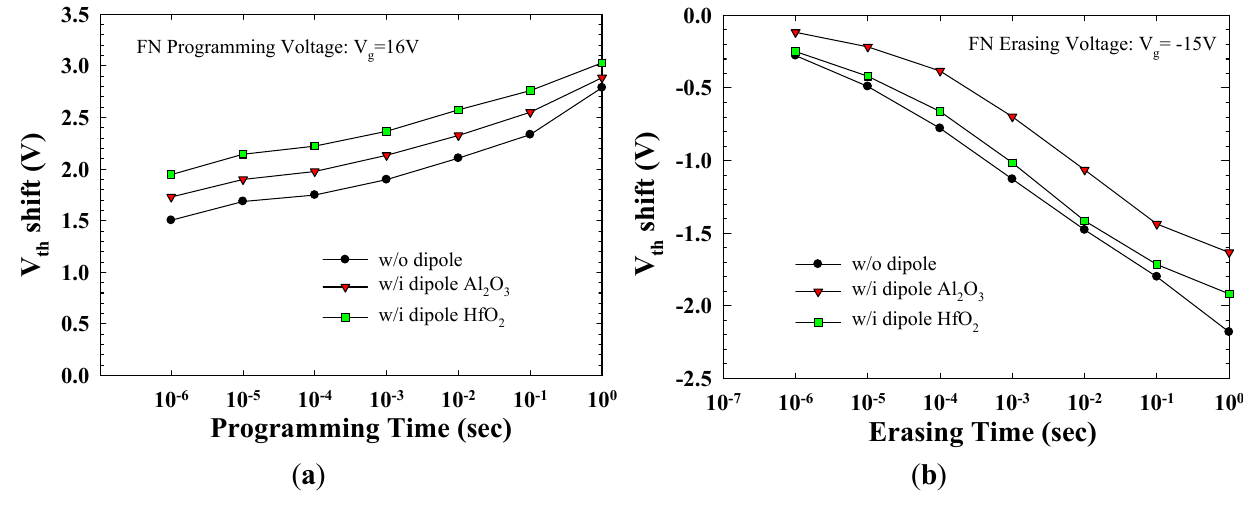
Figure 4. ( a ) Program characteristics of the TAHOS NVM devices; ( b ) Erase characteristics of the TAHOS NVM devices.